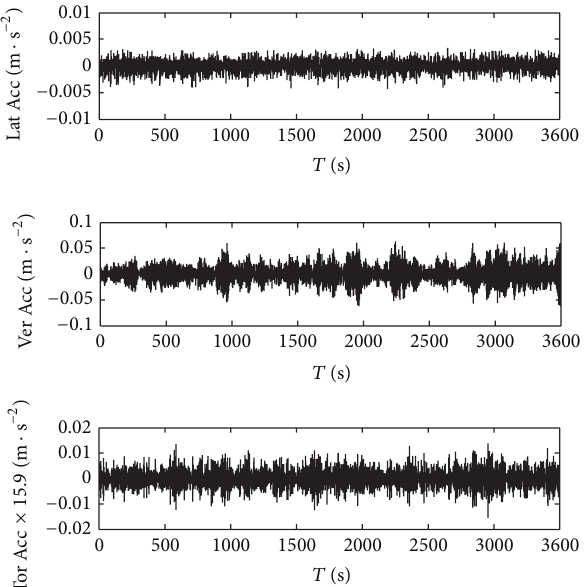
Figure 15: Measured lateral, vertical, and torsional